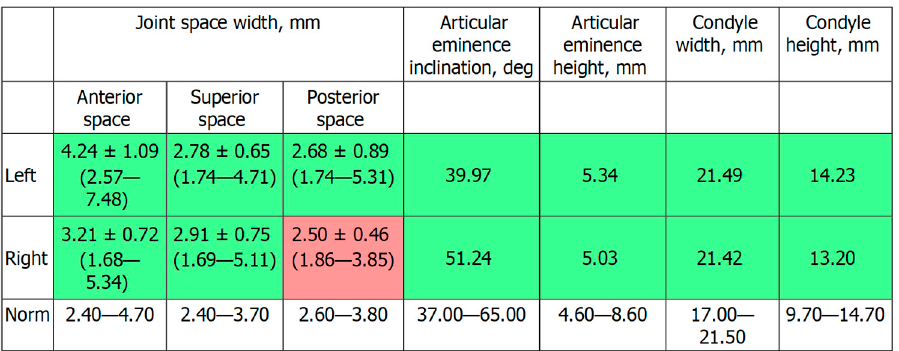
Figure 3. Table showed by the software. Intra-articular TMJ space widths before treatment. As represented in red, the posterior space width appears reduced with respect to normal values on the right TMJ.